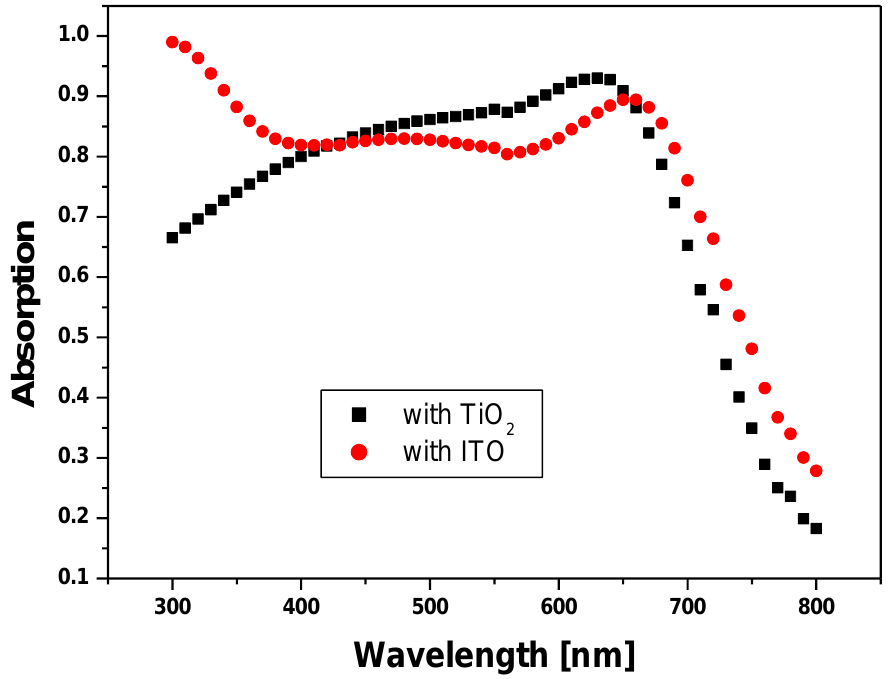
Figure 13. Hydrogenated amorphous silicon solar cell (a-Si: H) absorption spectrum with ternary anti-reflective coating, as in Figure 9, is represented by the black line. The replacement of the layer of titanium dioxide with indium tin oxide is represented by the red line.